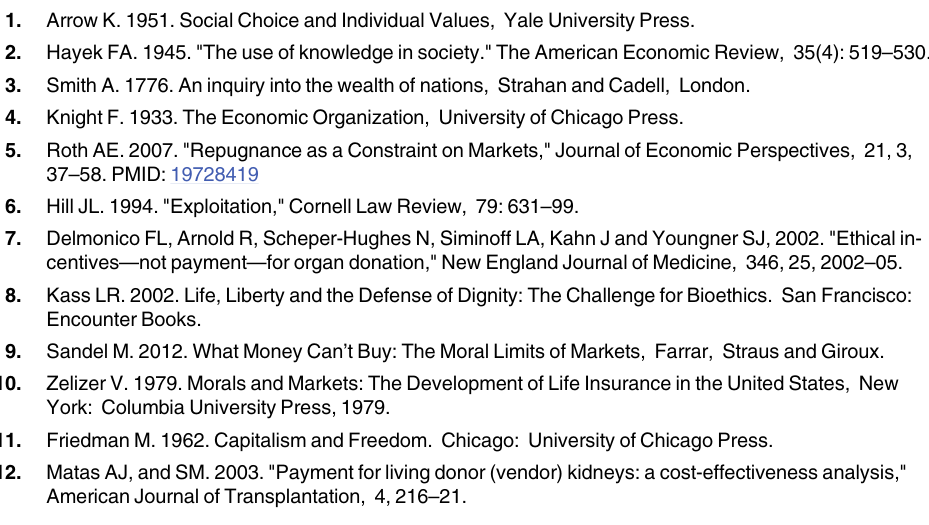
S1 Table. Descriptive statistics on individual characteristics collected from the survey, over- all and by experimental condition. Notes: ( (cid:3) ) 1 = No text, 4 statements; 2 = No text, 5 state- ments (organ payments); 3 = No text, 5 statements (prostitution); 4 = Organs text, 4 statements;